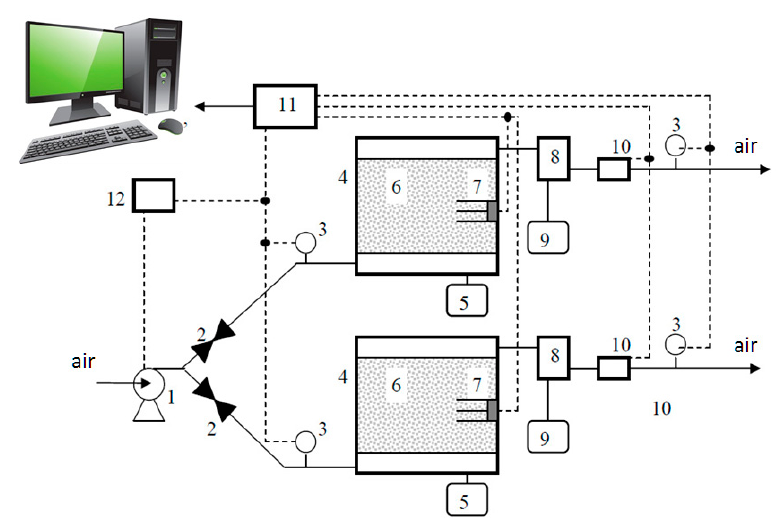
Figure 1. A diagram of a bioreactor used at the Ecotechnology Laboratory: 1—pump,